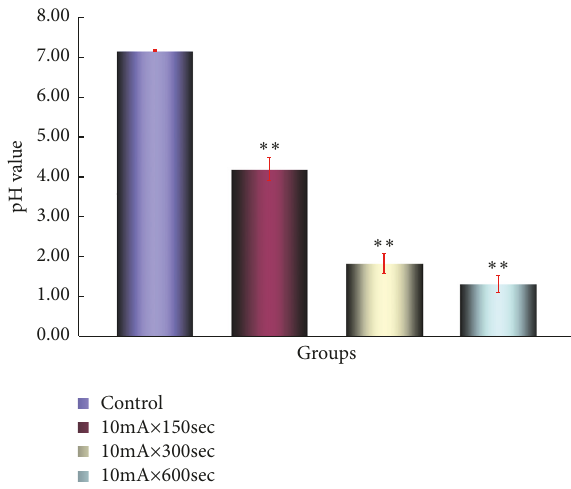
Figure 9: pH in the tumor on the anode side. Each bar rep- resents the mean value SE for 5 points from 8 to 10 mice.. Significantly different ∗ p < 0.05 , ∗∗ p < 0.01 control vs. 10mA × 150sec, control vs. 10mA × 500sec, control vs. 10mA × 300sec, 10mA × 150sec vs. 10mA × 500sec, and 10mA × 150sec vs. 10mA × 300sec.